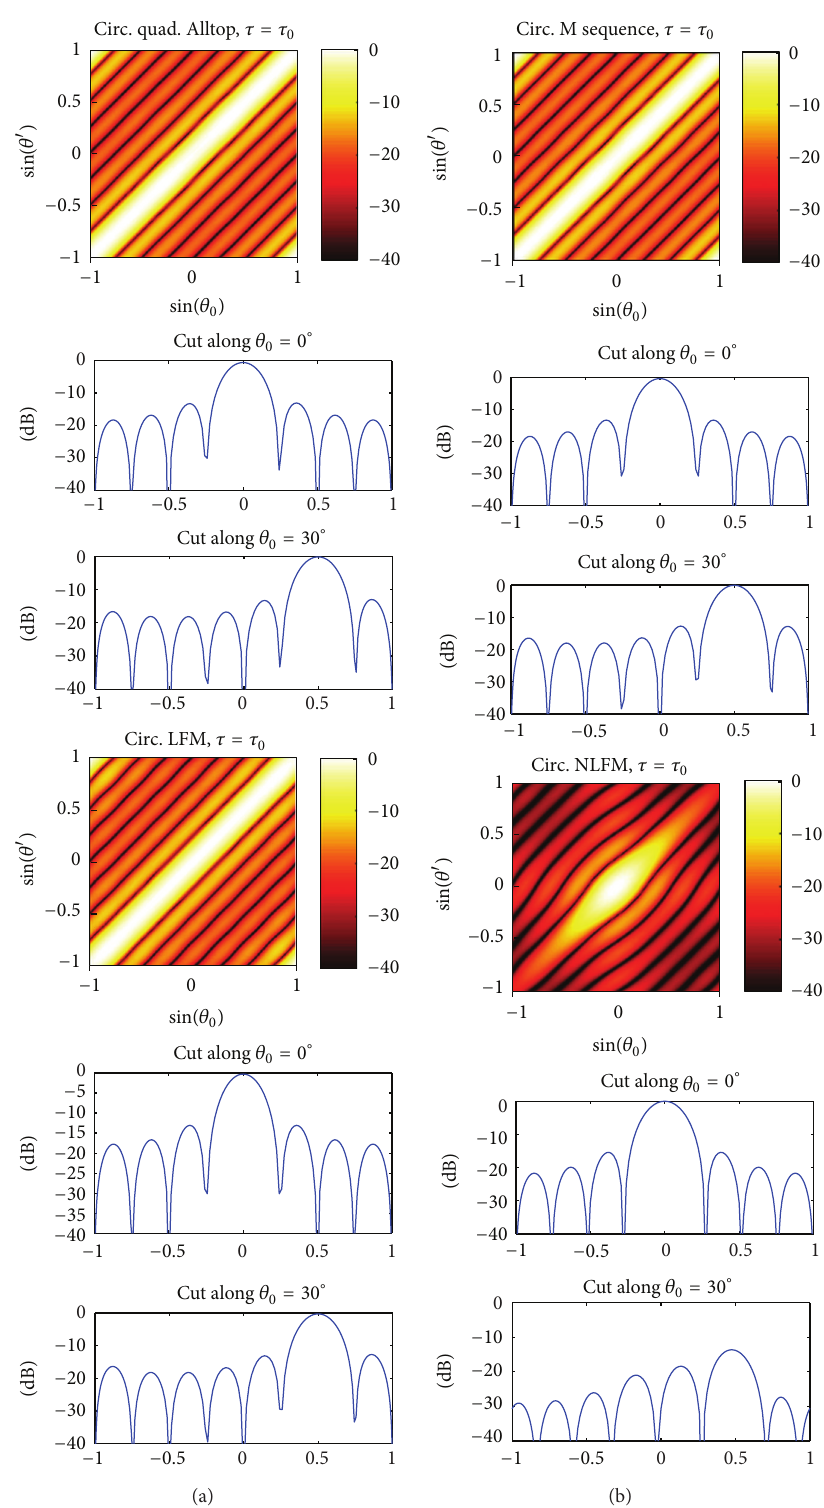
(𝜏 󸀠 ,𝜃 󸀠 )| 2 at 𝜏 󸀠 = 0 in 0